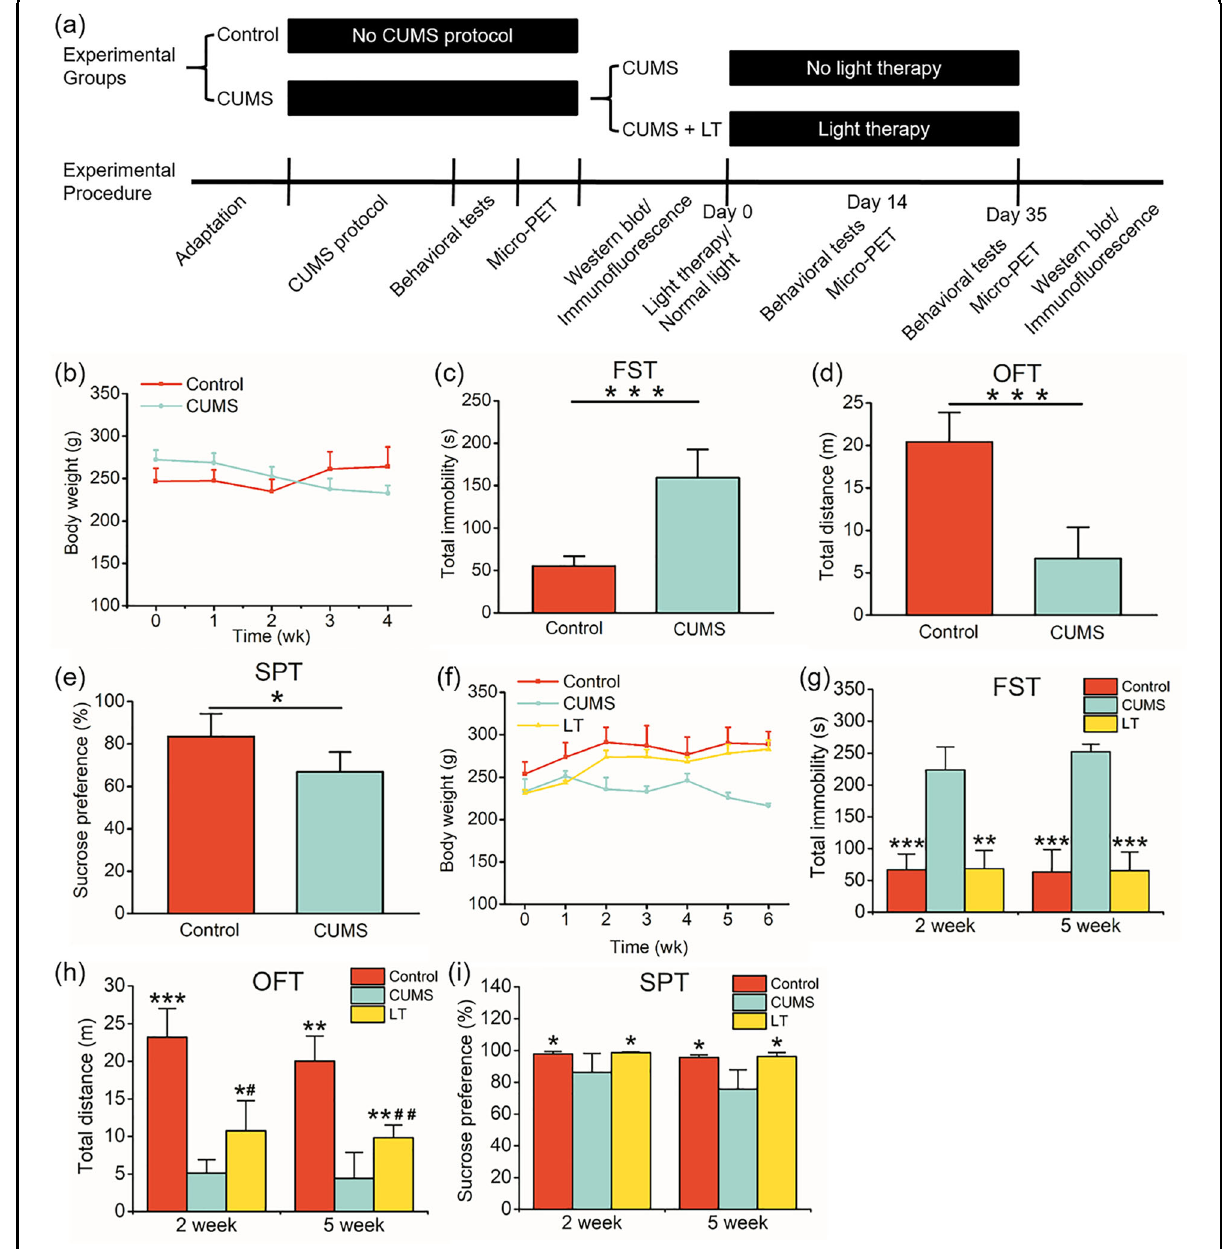
Fig. 1 The results of behavioral tests. a The experimental design diagram. b The changes in body weight of rats during the modeling of CUMS. The results of the ( c ) FST, ( d ) OFT, and ( e ) SPT after CUMS modeling. f The changes in body weight of rats during light therapy. The results of the ( g ) FST, ( h ) OFT, and ( i ) SPT after 2 weeks and 5 weeks of light therapy. * p < 0.05; ** p < 0.01; *** p < 0.001 compared with CUMS group; # p < 0.05; ## p < 0.01 compared with control group. FST forced swimming test, OFT open fi eld test, SPT sucrose preference test. n = 18/group for behavioral tests before light therapy ( b – e ). n = 6 (CUMS and LT) and n = 12 (control) for behavioral tests during and after light therapy ( f – i